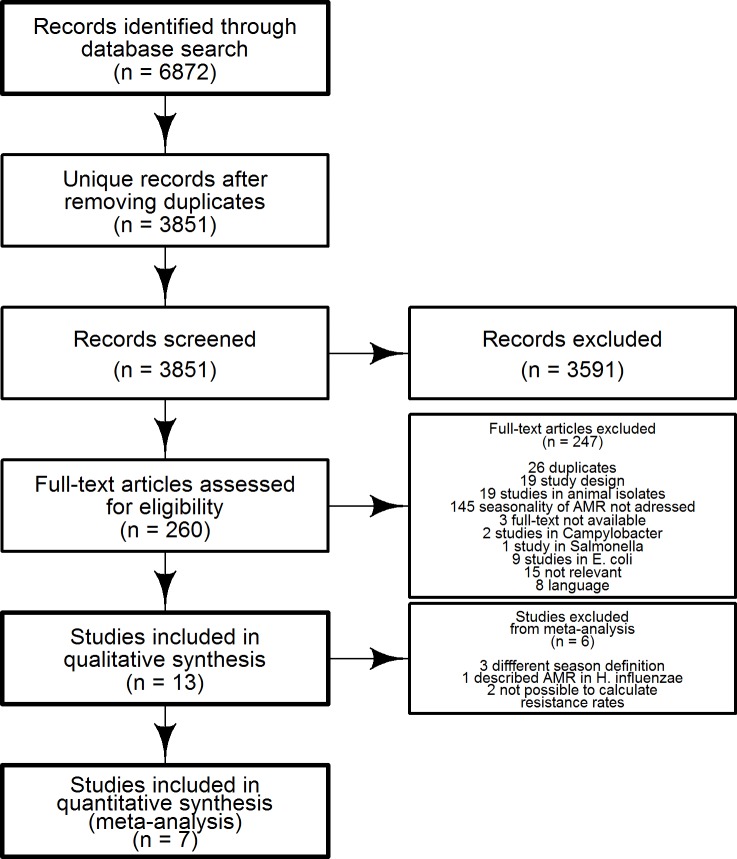
PRISMA flowchart summarizing the study selection process.